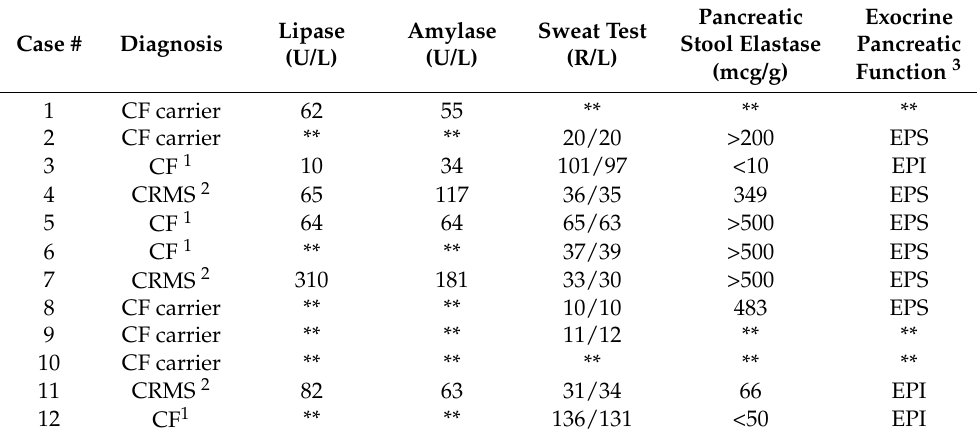
** Data unavailable. 1 CF: cystic fibrosis. 2 CRMS: CFTR -related metabolic syndrome. Pancreatic stool elastase (normal > 200 mcg/g) (severe < 100 mcg/g). 3 Cases were classified as either exocrine pancreatic insuffi- cient (EPI) or exocrine pancreatic sufficient (EPS) based on the reference values of pancreatic stool elastase (normal > 200 mcg/g or severe < 100 mcg/g). The mutations F508del (c.1521_1523del), V201M (c.601G > A), I507del (c.1519 1521del), and L1335P (c.4004T > C), which were present in two or more cases, were considered for the calculation of the PIP score. F508del obtained a PIP score of 0.25 in our cohort and 0.88 in the CFTR2 database, V201M PIP scores of 0.00 and 0.23, I507del PIP scores of 1.00 and 0.89, and finally, L1335P PIP scores of 0.50 and 0.37. V201M mutation was classified as mild in both PIP scores of 0.00 and 0.23. The CFTR2 database had a total of 53,480 EPI patients for